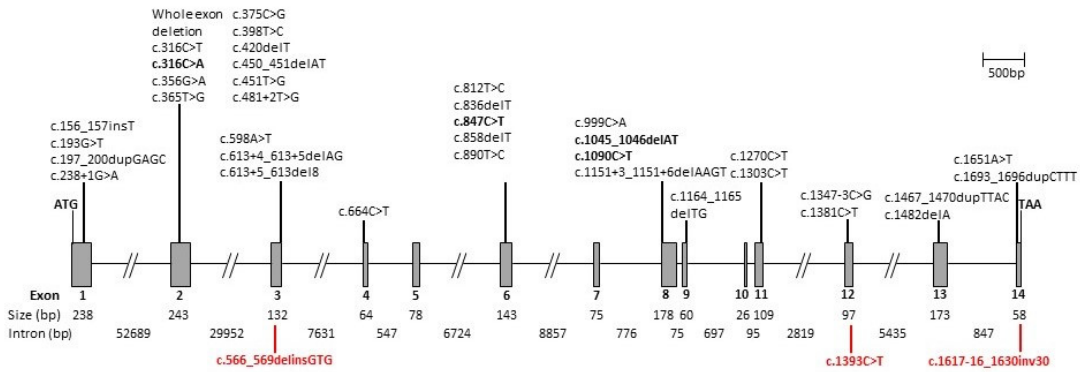
Figure 1. Schematic diagram of the CERKL genomic locus and location of identified mutations.